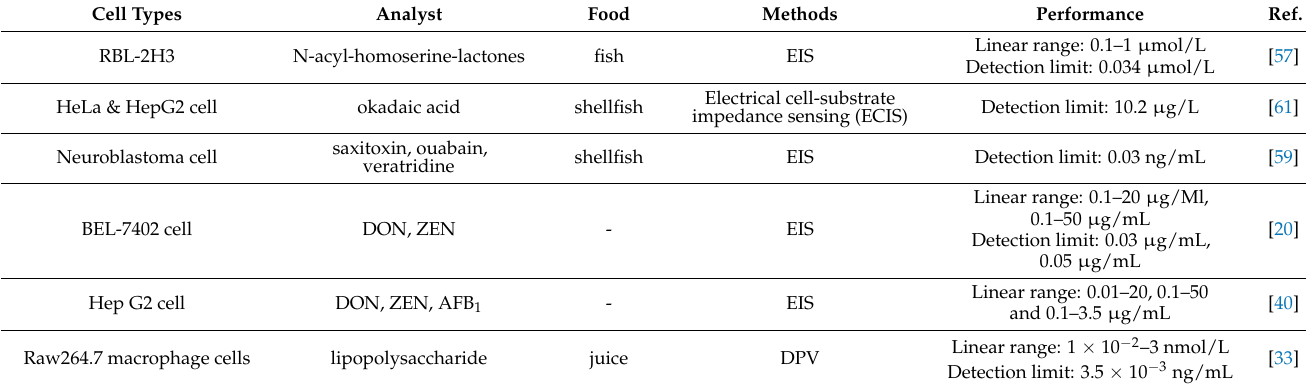
Figure 4. Schematic illustration of the construction and working principle of the miniaturized paper-supported 3D cell-based electrochemical sensor [33]. Copyright © 2020, American Chemical Society. Table 3. Application of electrochemical cell-based sensors in detection of food